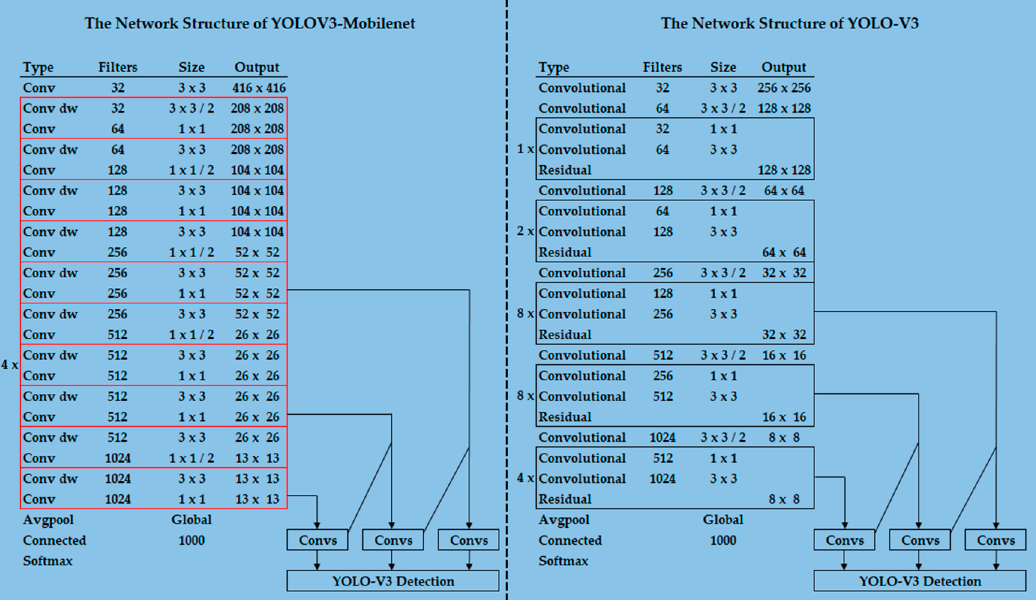
Figure 9. Network parameters of YOLOV3–Mobilenet and YOLO V3.